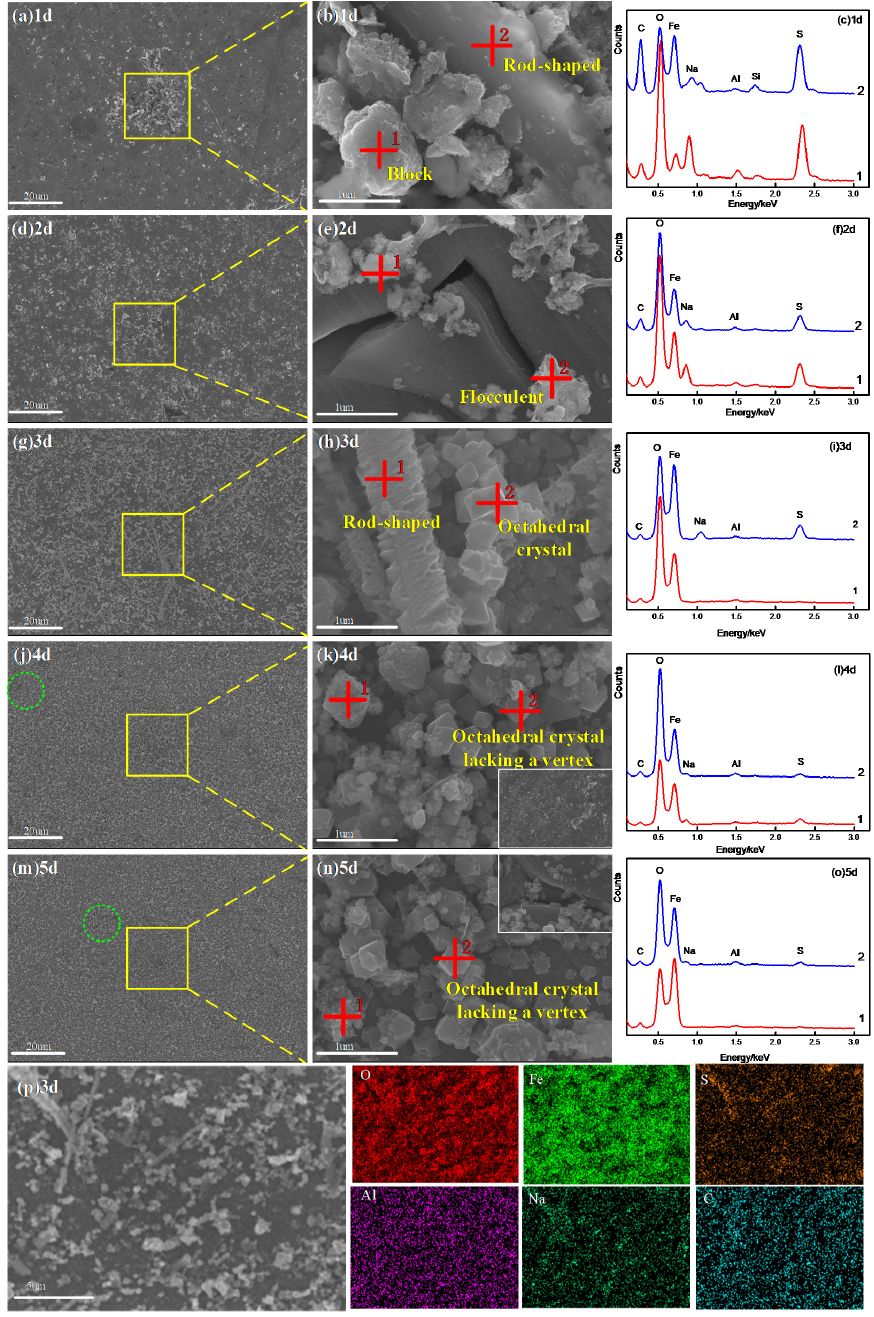
Figure 3. SEM morphologies ( a , b , d , e , g , h , j , k , m , n ), EDS analysis ( c , f , i , l , o ) and element distribution ( p ) of the corrosion products on the Q235 steel surface, with the following different corrosion times: ( a – c ) 1d; ( d – f ) 2d; ( g , h , i , p ) 3d; ( j – l ) 4d; and ( m – o ) 5d.